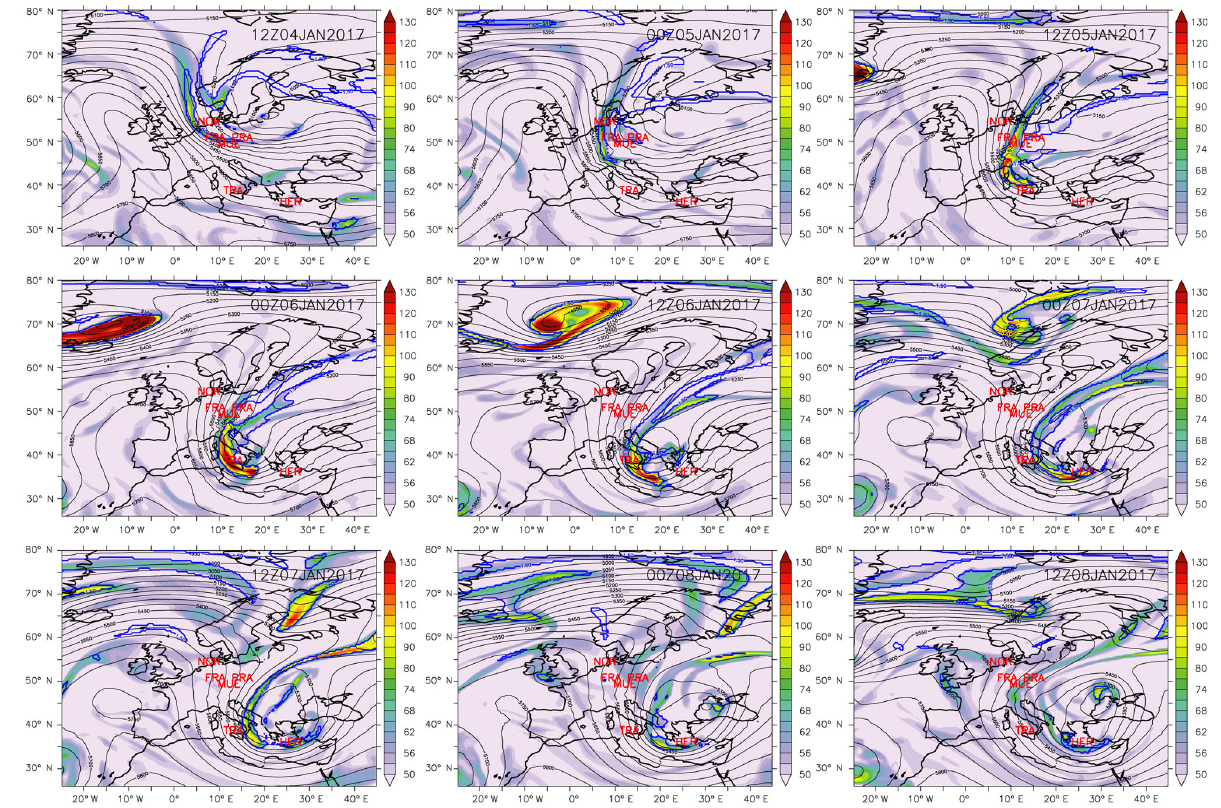
Figure 3. IFS ozone mixing ratio (in ppb; colour shaded), geopotential height (in gpm, black contours) and PV (1.5pvu; blue contours) at 500hPa during the period from 12:00Z on 4 January 2017 to 12:00Z on 8 January 2017 (12h interval). Also shown are the locations of the observational sites (red text) used in the